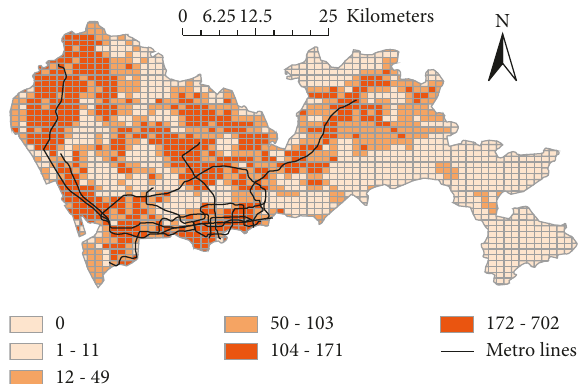
Figure 2: Job POI density in